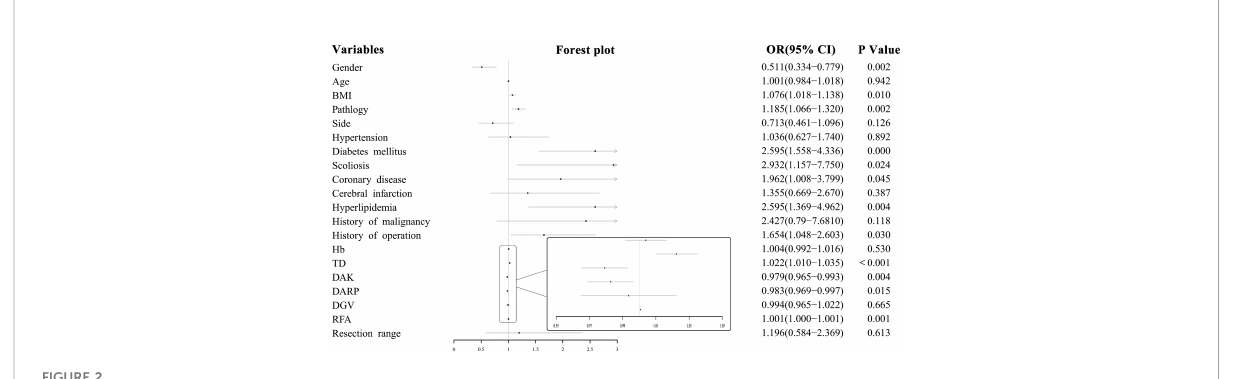
FIGURE 2 Forest plot of in fl uencing factors of surgical dif fi culty.